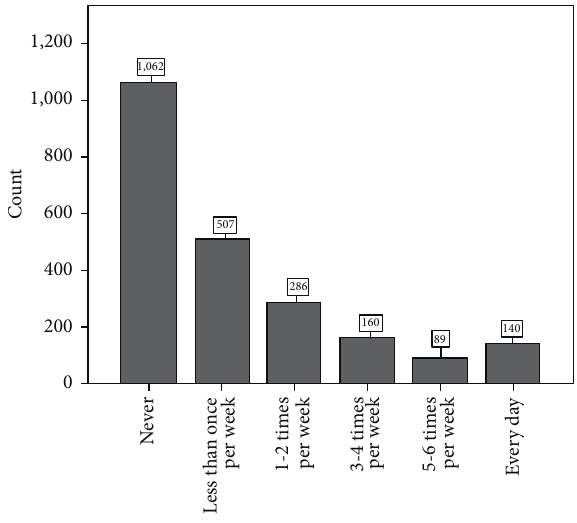
Figure 1: Meditation frequency of survey